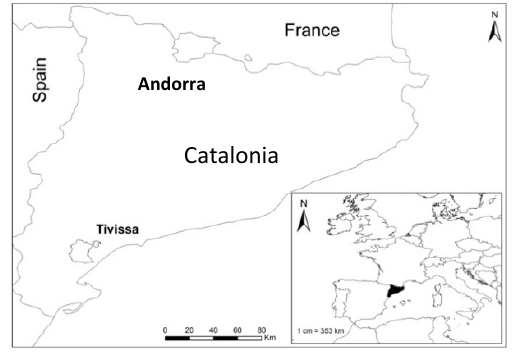
Figure 2. Location of the study area of Tivissa in the south of Catalonia.